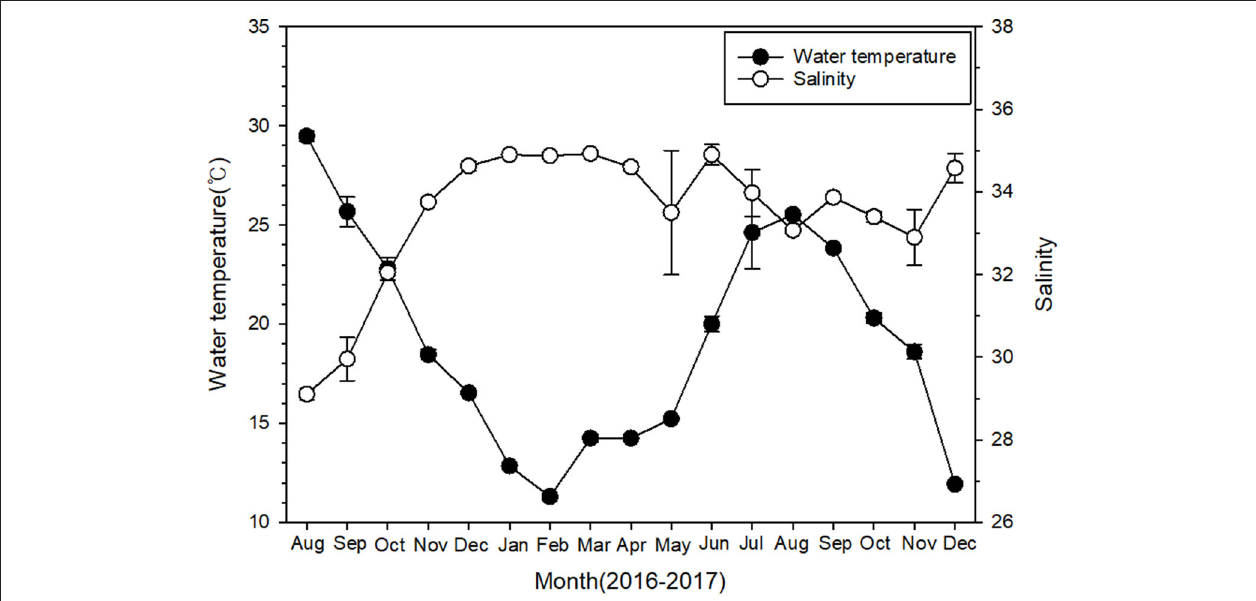
FIGURE 2 | Temporal variations of surface water temperature and salinity at four monitoring sites near Pohang during 2016–2017. Data are given as mean ± SE.